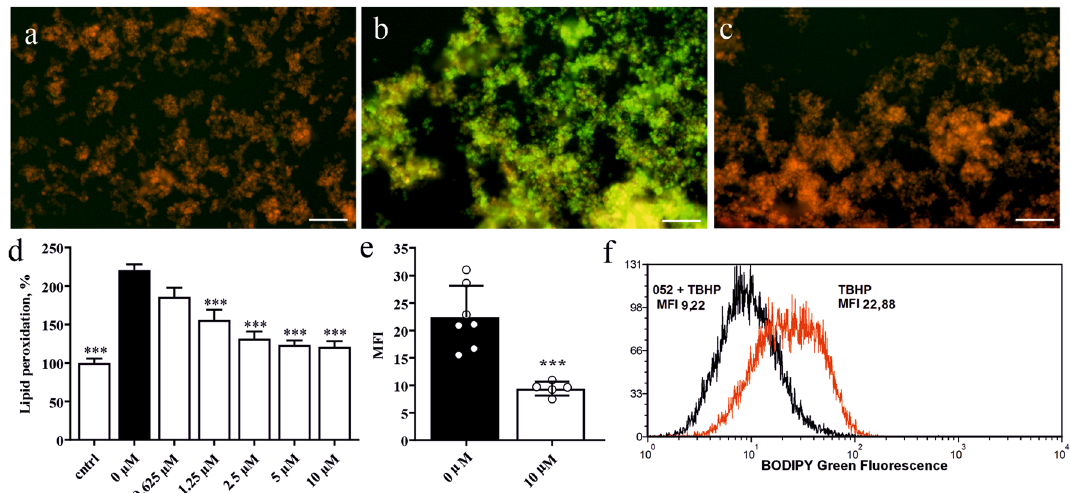
Figure 1. ADA-409-052 treatment protects PC-12 cells from TBHP-induced LP visualized with C11-BODIPY, a marker for cellular and intramembrane LP. (a–c) Representative, microscopic pictures of PC-12 cells exposed to (a) media control, (b) 1 mM TBHP, a class IV ferroptosis inducer, or (c) TBHP and ADA-409-052 (10 µM); scale bar: 100 µm. (d) Quantitative analysis of LP detected by a shift in the fluorescence signal. Data normalized to control and displayed as percentage ± s.e.m.; n = 3; One-way ANOVA with Tukey’s multiple comparison test; ****p < 0.0001. (e) Flow cytometry analysis of TBHP-exposed (500 µM) PC-12 cells demonstrated protection upon the addition of 10 µM ADA-409-052. Data are shown as the averaged green channel (488 nm laser, 530/30 filter) median fluorescence intensity (MFI) ± s.e.m.; n = 6/5. Unpaired, two-tailed student’s t-test; ***p < 0.001. (f) Representative histogram showing the median of the detected green fluorescence intensity (log values) after TBHP treatment only (red) or TBHP and ADA-409-052 (black) using flow ADA‑409‑052 prevents ferroptosis induced by glutathione depletion. High extracellular con- centrations of glutamate cause GSH-depletion by inhibiting the cysteine/glutamate antiporter system x c −22 . This depletion inhibits GPx4-activity, thereby initiating ferroptosis. Figure 2c,d show that 20 mM glutamate alone resulted in over 90% death of PC-12 cells, while glutamate-exposure in combination with 5, 10, or 20 µM ADA-409-052 rescued more than 90% of the cells (cell survival ADA-409-052: 5 µM: 92.18% ± 4.45%, 10 µM: 96.2% ± 3.98%, 20 µM: 91.53% ± 2.52%; p < 0.0001; Fig. 2c). In contrast, minocycline was less protective at corre- sponding concentrations (cell survival minocycline: 10 µM: 24.86% ± 2.52%; 20 µM: 49.96% ± 5.02%; p < 0.0001, Fig. 2d). To demonstrate that the efficacy of ADA-409-052 is independent of endogenous GSH, we deter- mined the intracellular GSH levels in glutamate-exposed PC-12 cells. We found that ADA-409-052 prevented glutamate-exposed cell death efficiently (20 mM Glu: 10.87% ± 0.57%; Glu + ADA-409-052: 95.67% ± 0.95%; p < 0.005; Fig. 2e). Also, the GSH levels in both glutamate only and glutamate plus ADA-409-052 co-treated cells were significantly reduced compared to unstimulated cells (GSH-levels of: 20 mM Glu: 37.8% ± 6.8%; ADA-409- 052: 43.4% ± 6.3%, unstimulated control cells were normalized to 100%; p < 0.0001, Fig. 2f). ADA‑409‑052 prevents changes in mitochondrial morphology in glutamate‑exposed PC‑12 cells. Mitochondrial fragmentation is a major morphological alteration in ferroptosis, also when induced by high concentrations of glutamate 23–26 . We thus tested whether ADA-409-052 prevents such changes in mito- chondrial morphology of PC-12 cells exposed to ferroptosis stimulation 23 . Live cell imaging of MitoTracker Red CMXRos stained mitochondria showed similar morphology of control, ADA-409-052, as well as glutamate and ADA-409-052-co-treated cells without signs of fragmentation (Fig. 3a–c,d–g). In contrast, glutamate-exposed cells show clear signs of pronounced fragmentation and reduced mitochondrial density (Fig. 3d,h), comparable with data shown elsewhere 23,26 . ADA‑409‑052 inhibits inflammation in an in vitro model of LPS stimulation. Lipopolysaccha- ride (LPS) stimulates inflammatory activation of microglial BV2 cells, which is associated with a redox imbal- ance. We assessed the expression of inducible nitric oxide synthase (iNOS) by measuring the release of nitric oxide (NO) into the culture medium 24 h after administration of 50 ng/ml LPS. Co-administration of LPS with ADA-409-052 yielded a dose-dependent reduction in NO release (5 µM: 92.42% ± 4.38%; p = 0.0384; 10 µM: 72.33% ± 6.65%, 20 µM: 60.03% ± 9.53%; p < 0.0001; Fig. 4a). ADA‑409‑052 is neuroprotective in a co‑culture model of N2a cells and stimulated RAW 264.7 macrophages. To determine whether ADA-409-052 protects against inflammation-mediated neuronal death, we exposed co-cultures of N2a cells and RAW 264.7 macrophages to 25 ng/ml LPS and 25 ng/ml inter- feron gamma (IFN-γ) for 24 h. The exposure resulted in about 40% neuronal cell death when compared with vehicle treatment (LPS/IFN-γ: 60.15% ± 2.28% viability; p < 0.0001). ADA-409-052 improved N2a cell viability